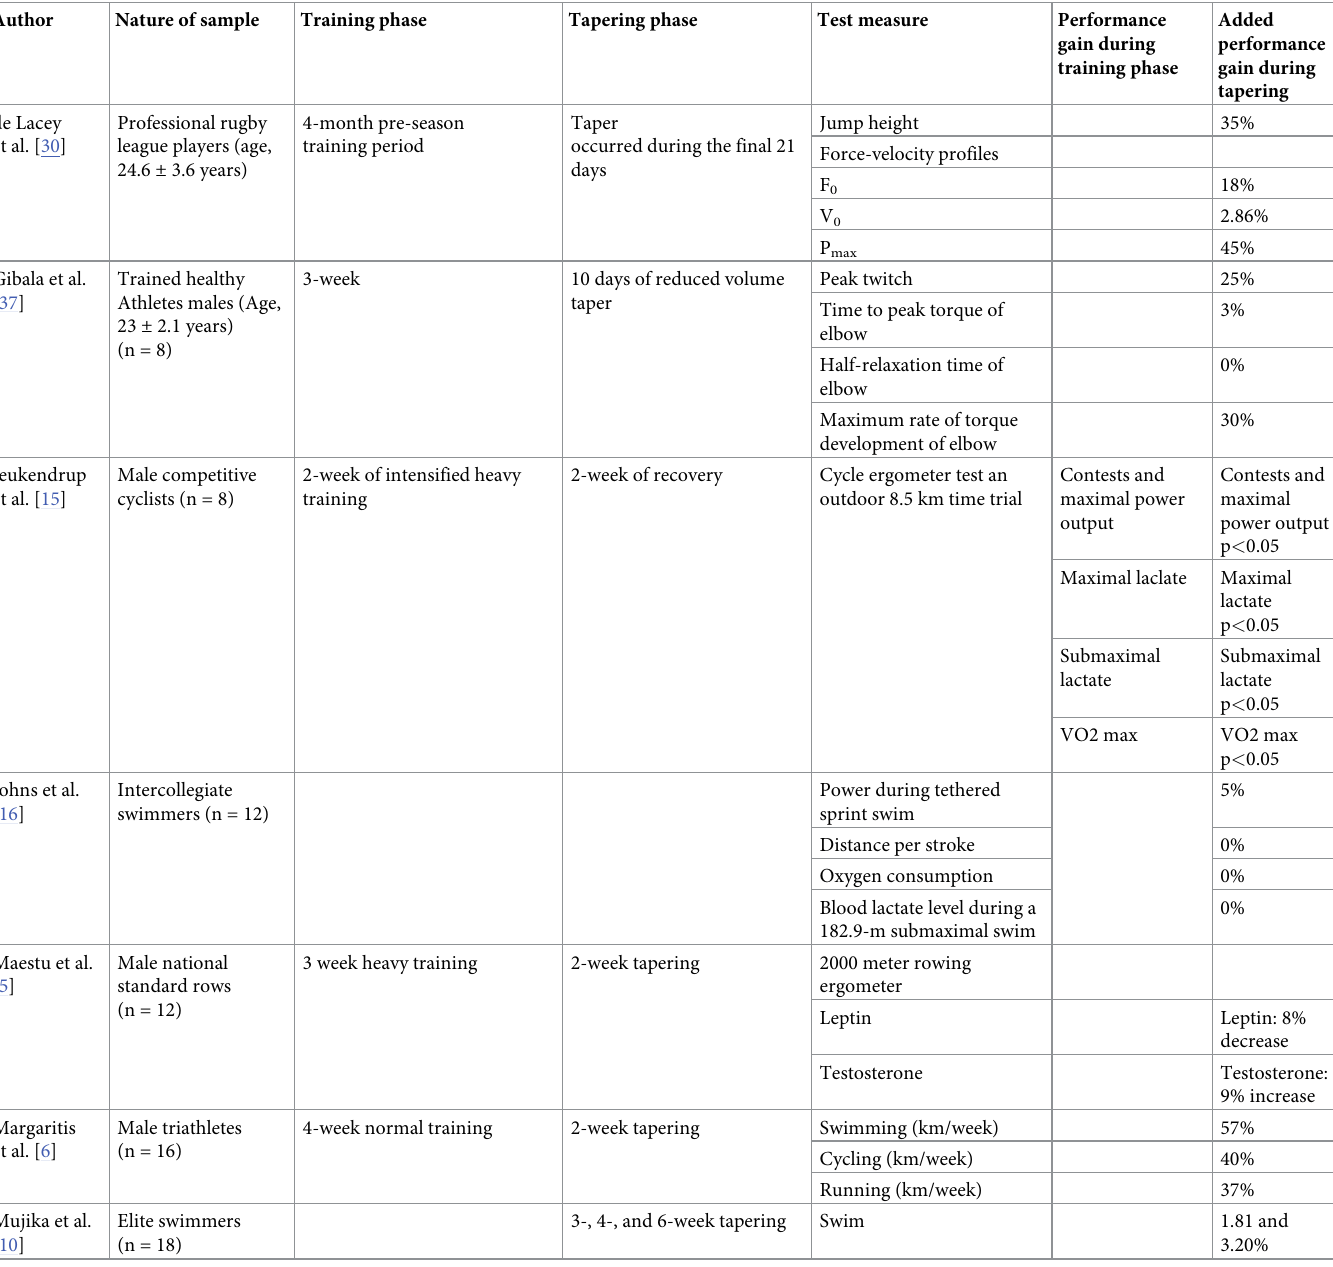
Table 4. Effectiveness of various types of training and tapering phases on performance of different level and sport practice